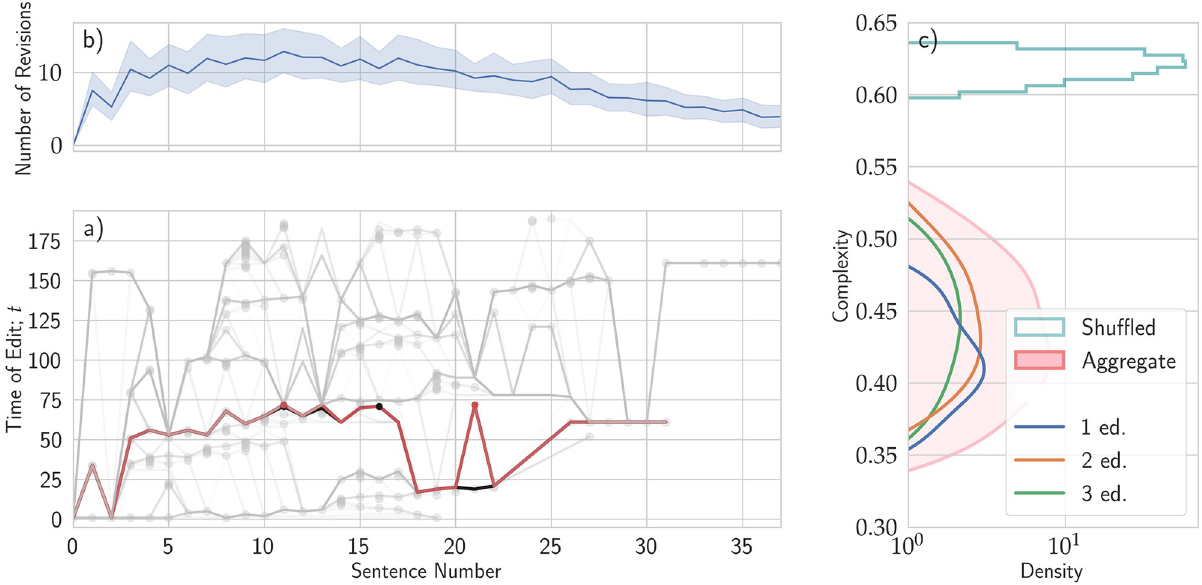
Fig 1. Complexity of the writing process. (a) The cloud of all versions of the text produced by a generic author. Each sentence written, even those deleted in the ongoing process, is represented as a point in this graph. The position on the horizontal axis represents the ordinal location of a sentence in a given draft version, the Sentence Number. The position on the vertical axis represents the version of the draft a sentence first appeared in, the Time of Edit t . A point in { x , t } is a sentence first appearing as the x th sentence of the t th version of the draft. Focusing on a specific Time of Edit, the image shows all the sentences that have been revised at that time. Focusing on a particular Sentence Number, the image shows all the times at which that sentence has been edited. Each version of the draft is displayed by drawing a semi-transparent line through its ordered component sentences. Sequences of sentences preserved among different draft versions are more opaque. An example of two consecutive versions of the draft is highlighted in black [version 70] and red [version 71]. The 21 st sentence of version 70, first appearing in version 20, has been edited in version 71. (b) We report the average number of edits of each sentence across all authors. The horizontal axis displays the position of each sentence in the text, while the vertical axis reports the number of edits. The blue area denotes the 99.5% confidence interval over the distribution using the bootstrapping procedure [ N = 1000]. (c) The distribution of complexity values. The pink histogram displays the values of the complexity of the writing processes recorded over all the workshops. Shaded areas are kernel density estimates for the individual workshops. The cyan line displays the probability density function computed over versions generated by randomly permuting the sequence of